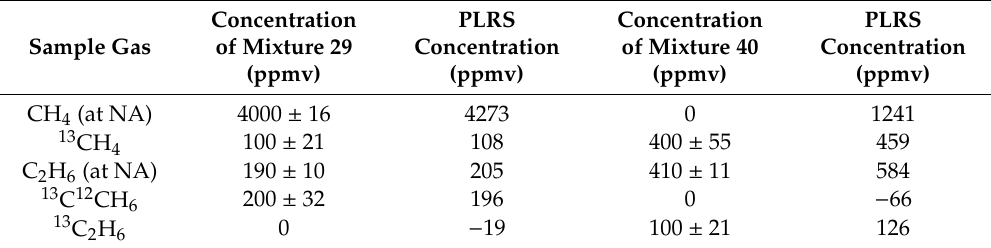
Figure 6. PA spectra measured with ICL 1541 of two multi-component mixtures with concentrations according to Table 3. Table 3. Concentrations of two exemplary chosen mixtures determined by the PLRS models.